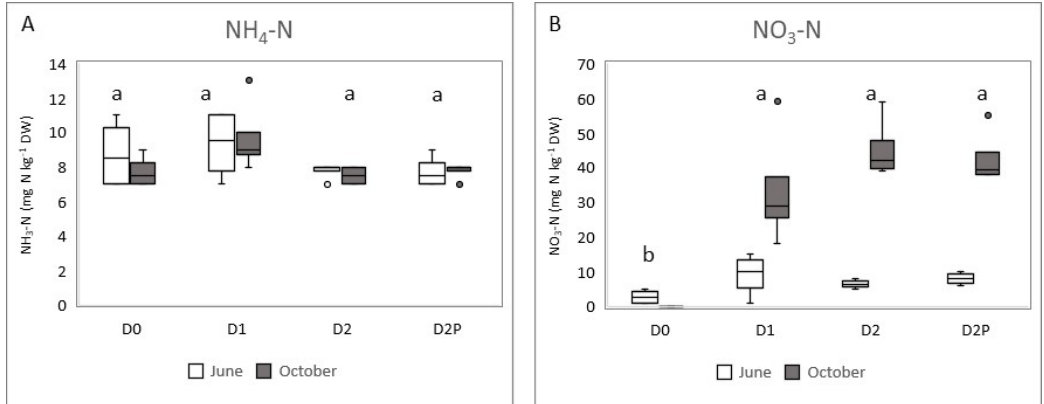
Figure 3. ( A , B ): Ammonia (NH 4 -H) and nitrate (NO 3 -N) concentration (expressed in mg N kg − 1 of dry weight, DW) in the soil before (June) and after irrigation (October). Different letters above groupings indicate significant differences at p < 0.05.